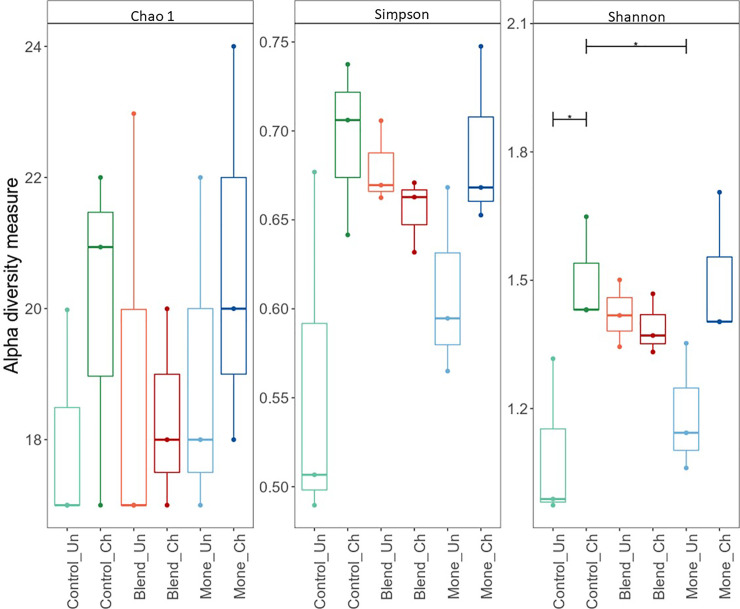
Alpha diversity at the family level in the small intestinal digesta of broiler chickens at 28 days of age.Experiment consisted of three feeding treatments: basal diet (control), sodium monensin (Mone), or oil blend, with (CH) or without (UN) a coccidiosis sanitary challenge.